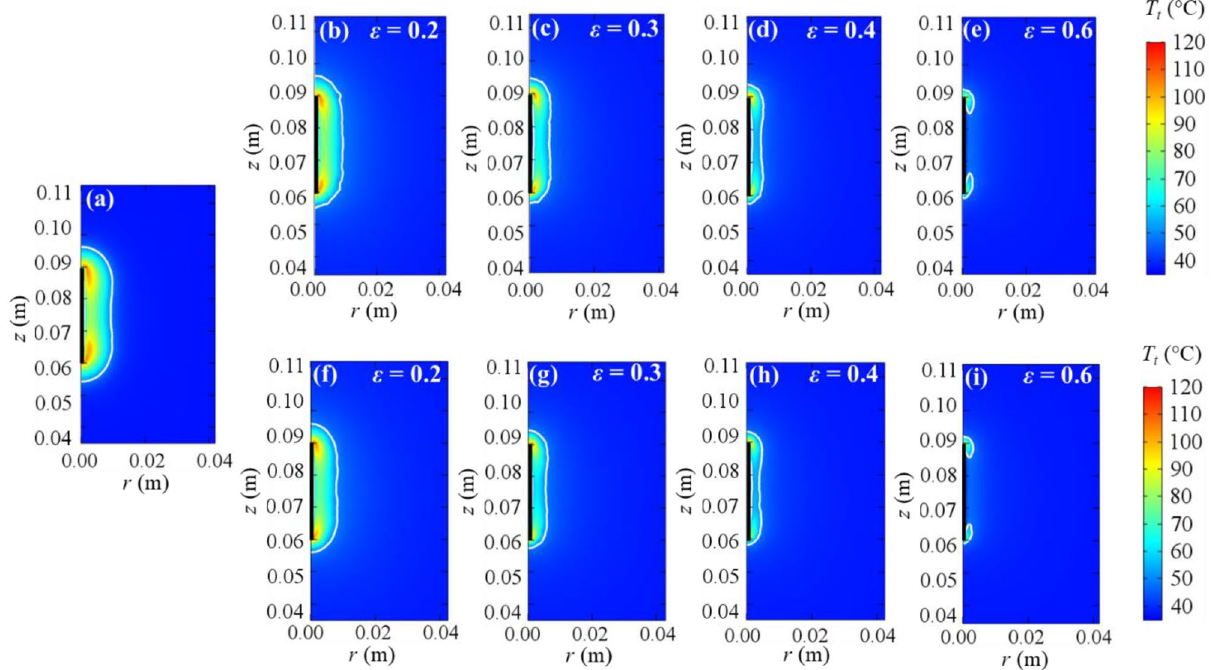
Figure 2. Tissue temperature distributions after 720 s of applying 45 V computed from Pennes’ bioheat model ( a ), LTE model ( b – e ), and LTNE model ( f – i ) for different porosity values ( ɛ ). White line represents coagulation zone contour. The thicker black line identifies the position of the electrode.